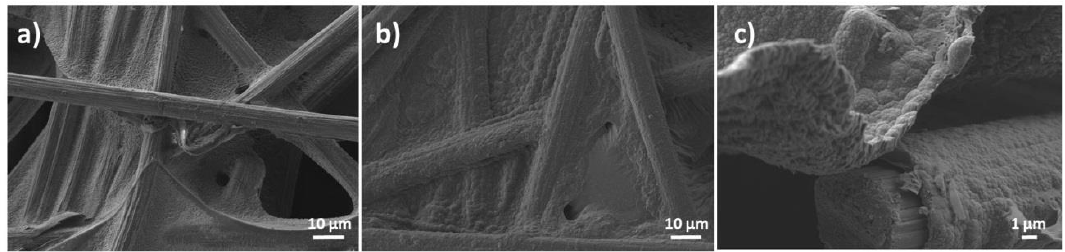
Figure 3. FE-SEM images of carbon fiber (CF) substrate before ( a ) and after modification with composite coating ( b , c ).